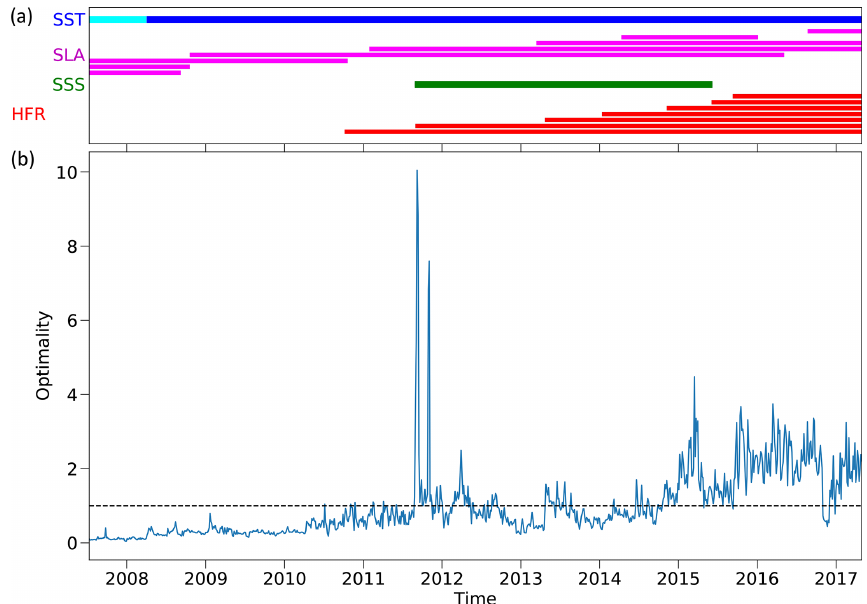
Figure 5. (a) Gantt chart of remotely sensed observations used in the study. (b) Optimality of I4D-Var data assimilation with the dashed line representing the theoretical